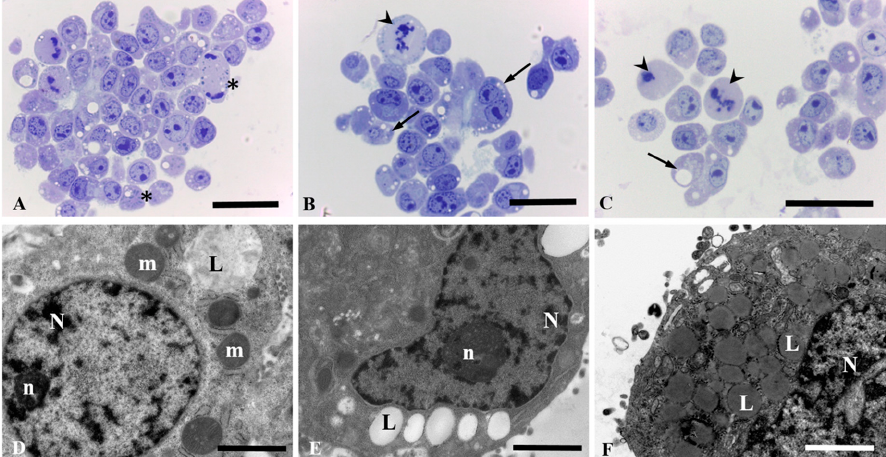
Figure 3. Morphology of HepG2 cells after 24 h of exposure to the extract observed by light microscopy ( A , B , C , bars = 25 μ m) and electron microscopy ( D , E , F , bars = 2 μ m). Unexposed control cultures ( A ) and HepG2 cells exposed to 7.79 μ g/mL of the stilbene extract (45%) ( D ), 15.59 μ g/mL of the extract ( B , E ) and 31.18 μ g/mL of the stilbene extract (45%) ( C , F ). ( A ) Unexposed cells undergoing mitotic processes (arrow heads). ( B ) and ( C ) Lipid degeneration with confluent lipid drops (arrow) and aberrant mitotic figures (arrow head). ( D ) Cells showing nucleus (N) and nucleolus (n); mitochondria (m); lipid drops (L). ( E ) Big lipid drops (L); nucleus (N) and nucleolus (n) are also observed. ( F ) High amount of lipid drops that tends to confluency (L).